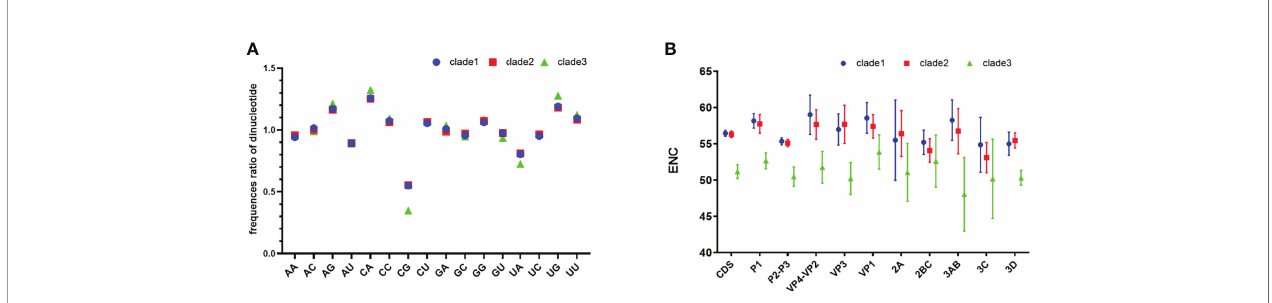
FIGURE 1 | Relative dinucleotide analysis and ENC plot. (A) Dinucleotide composition of EV-A clades. (B) Clade-level comparison of ENC values of EV-A CDS and individual gene segments. CDS is short for coding